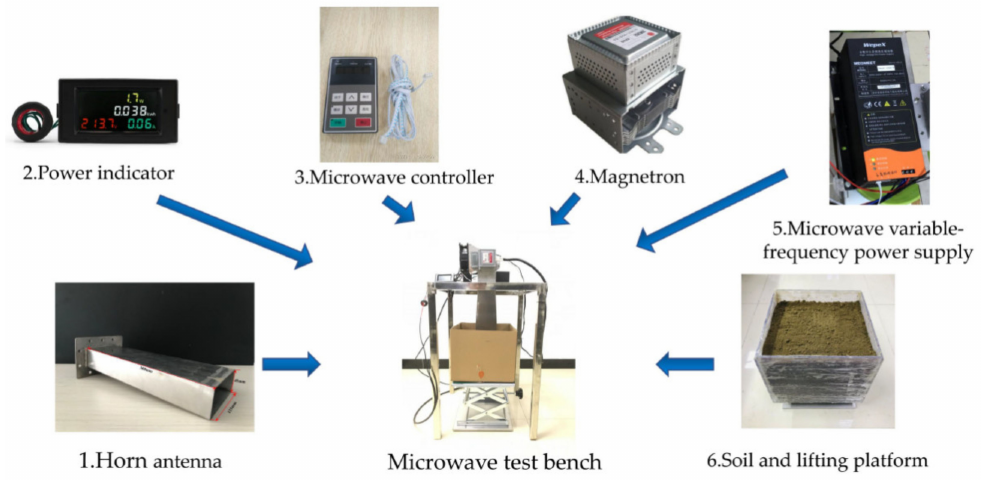
Figure 3. Microwave experiment bench